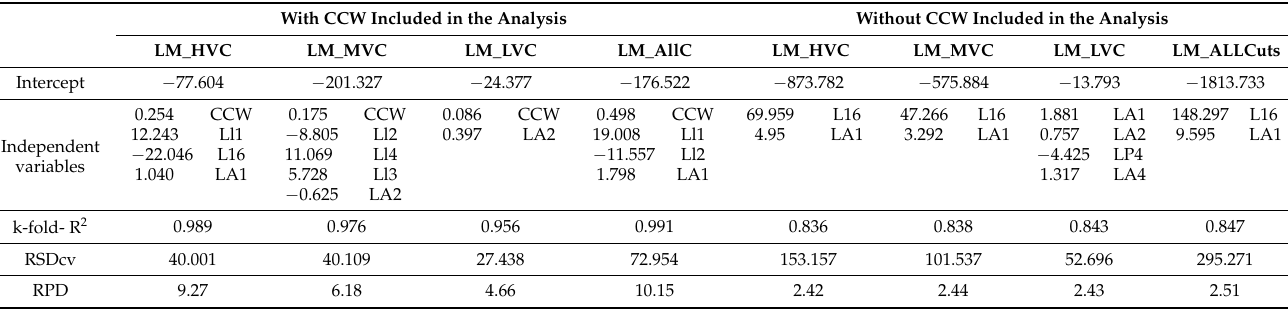
Table 5. Equations and corresponding coefficient of determination k-fold (k-fold- R 2 ), residual standard deviation of the cross-validation (RSDcv) and ratio of prediction to deviation (RPD) for the prediction of lean meat weight with and without cold carcass weight (CCW) included in the analysis ( n =